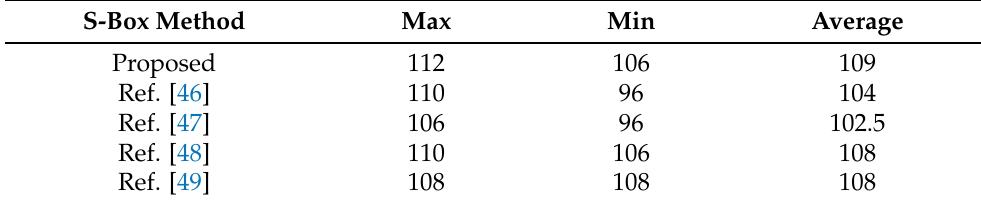
Table 9. Nonlinearity